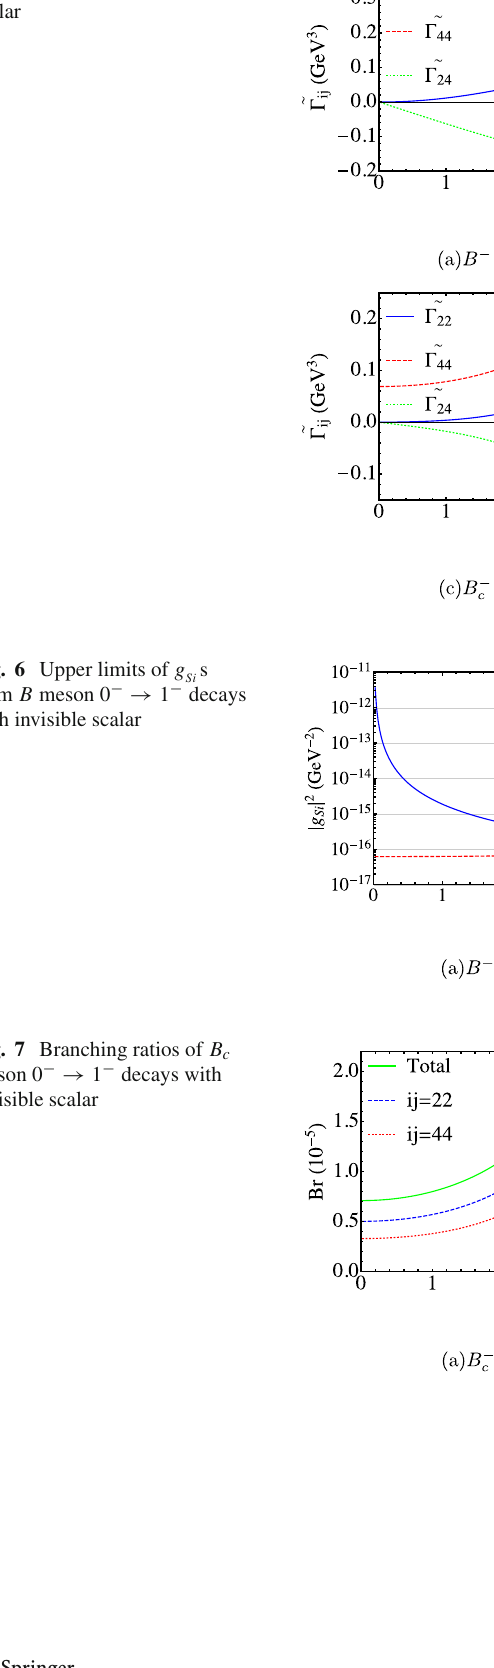
Fig. 5 (cid:6) (cid:8) ij s in B and B c meson 0 − → 1 − decays with invisible scalar